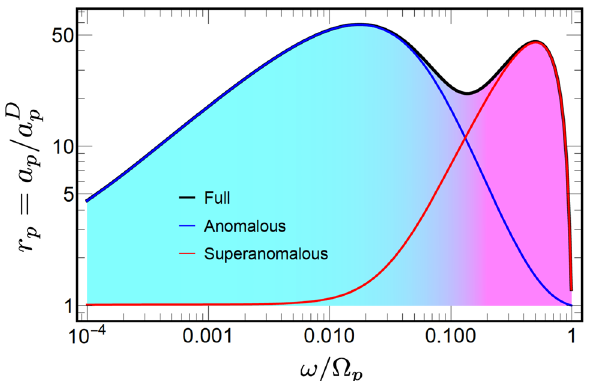
a p / a D Figure 8. Relative absorptivity r p p calculated for a Maxwell plasma, = model. The black line ”Full” gives a p of the full model in Eqs. (20), the solid blue line ”Anomalous” and the red line ”Superanomalous” show r p obtained using the A and S approximations, defined by Eqs. (9) and (10), respectively. The cyan and magenta colour filling shows the frequency intervals of the ASE and SASE. The 50 incident angle is θ ◦ . =